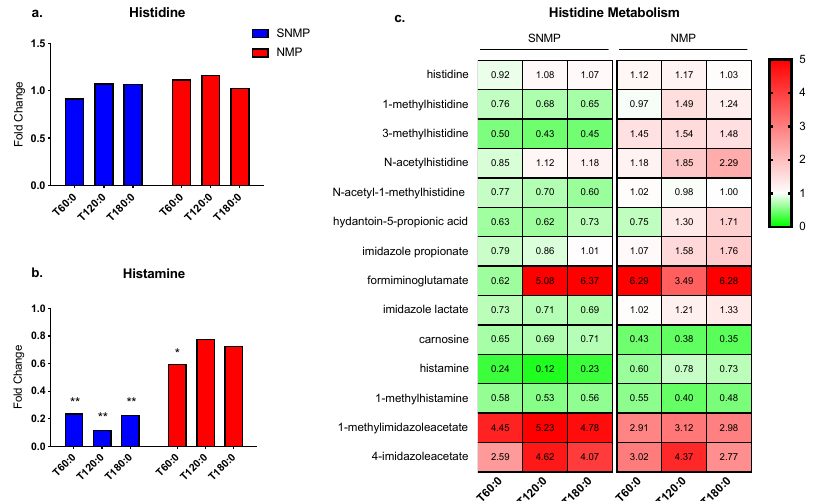
Figure 6. Histidine metabolism during SNMP vs. NMP. (a) Histidine concentrations are unchanged during SNMP and NMP, whereas (b) histamine tissue concentrations are significantly decreased during SNMP. (c) Heatmap showing concentration fold changes of histidine metabolites during SNMP and NMP. ** indicates p ≤ 0.05 and * indicates 0.05 < p < 0.10. Abbreviations: SNMP, subnormothermic machine perfusion; NMP, normothermic machine perfusion; x-axis represents fold change at 60, 120, and 180 min compared to pre-perfusion concentrations.